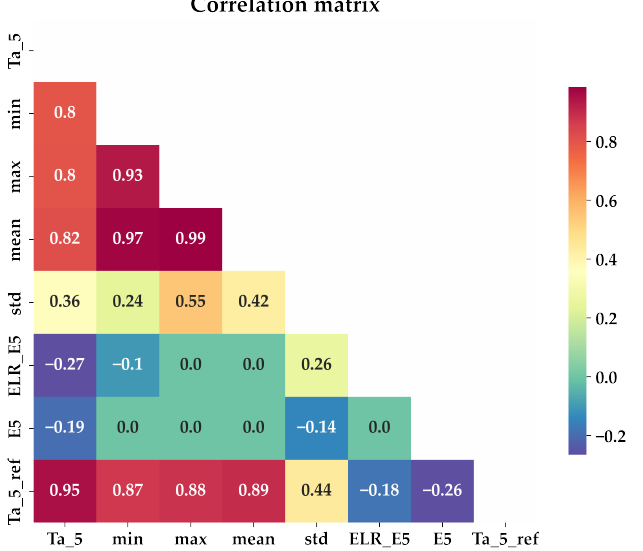
Figure 7. Correlation matrix results. PCC value of each two variables is shown in the boxes corre- sponding to their “coordinates”. ELR_E5, Std and E5 being the hourly ELR issued from Ta_5, the daily standard deviation, and ERA5-Land grids elevation,